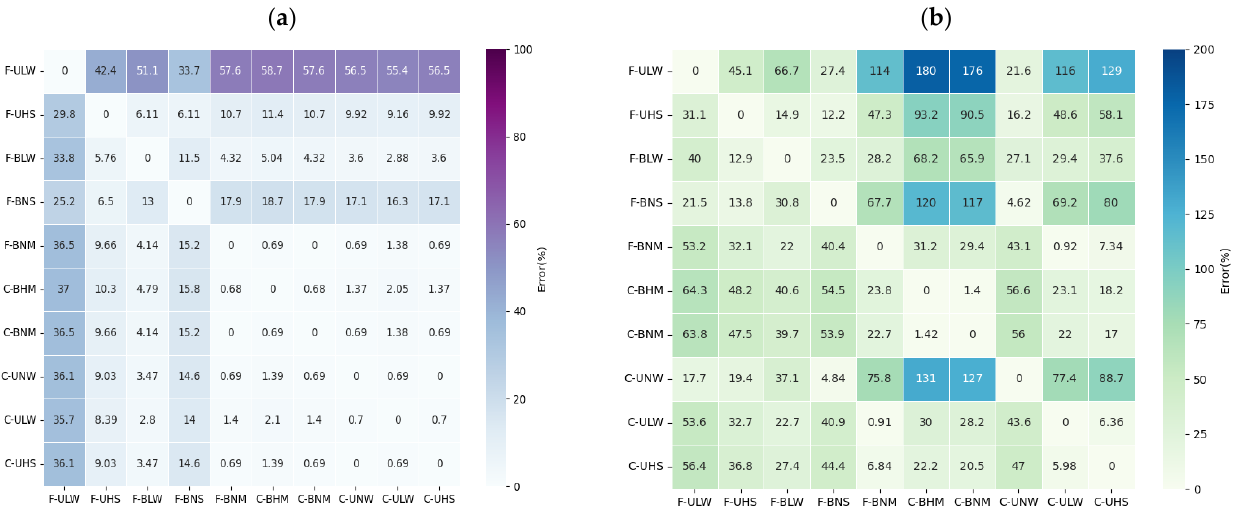
Figure 6. Heat maps of the absolute error corresponding to the posterior error caused by inaccurate aerosol models. ( a ) represents intensity measurements only; ( b ) represents “intensity + polarization” multi-angle measurements.